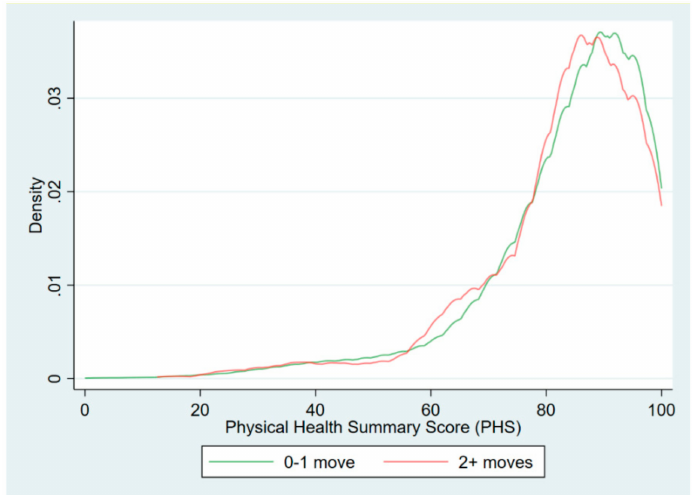
Figure A1. Distribution of Physical Health Summary